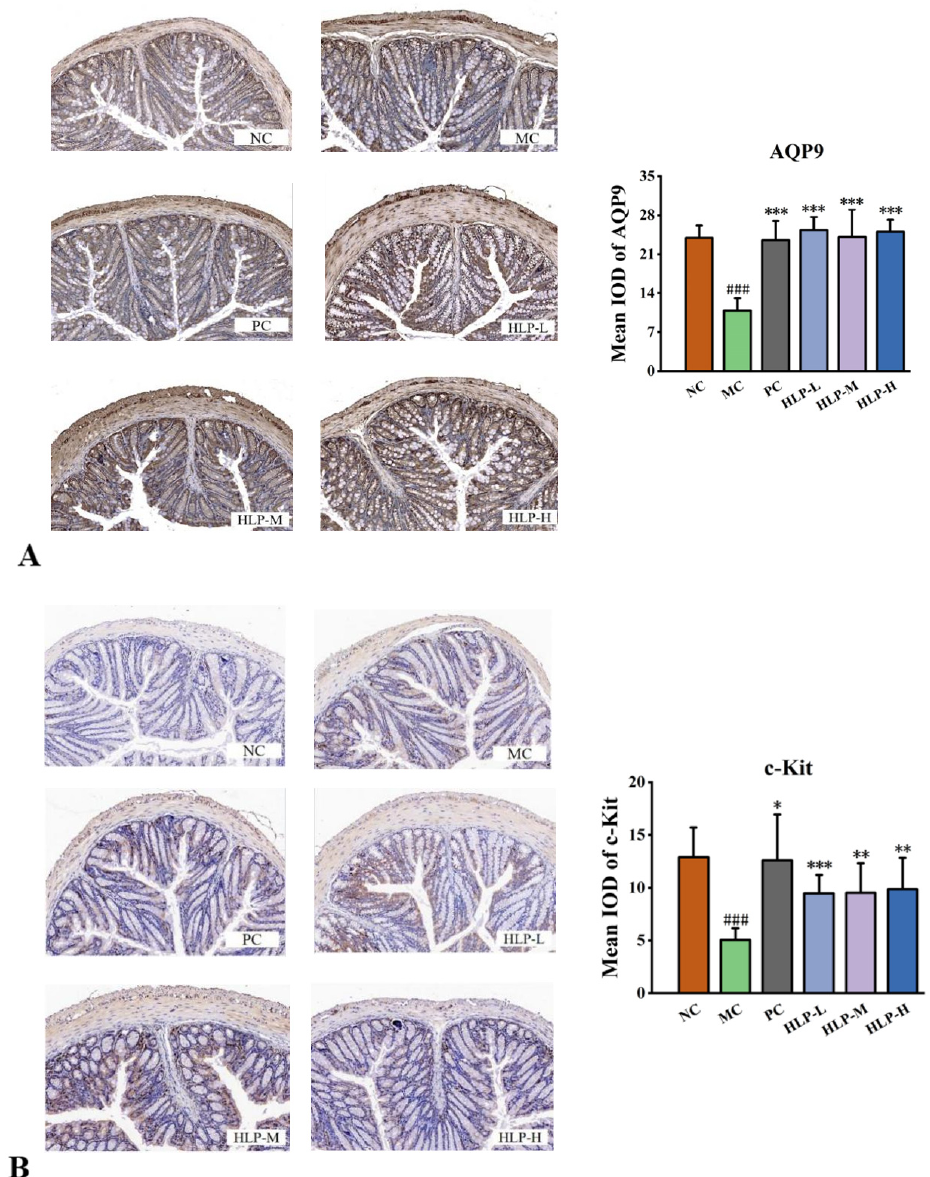
Figure 5. The expression of water metabolism and motility of intestinal tract-related genes and pro- teins. ( A ) AQP9 immunohistochemistry (200× magnification) and its mean IOD values in colon tis- sue. ( B ) c-Kit immunohistochemistry (200× magnification) and its mean IOD values in colon tissue. ### p < 0.001 vs. NC group; * p < 0.05, ** p < 0.01, *** p < 0.001 vs. MC group. NC: normal control group, MC: model control group, PC: positive control group, HLP-L: low-dosage HLP group, HLP- M: middle-dosage HLP group, and HLP-H: high-dosage HLP group. In the intestinal tract, AQPs play a vital role in the reabsorption and secretion of wa- ter and electrolytes [31]. The lack of AQP expression in the intestine in this experiment limits water transport across cellular pathways, leading to the reduction of fecal water content and the development of inflammation in constipated mice, which may also be a significant cause of constipation in mice. HLP promoted the balance of water and